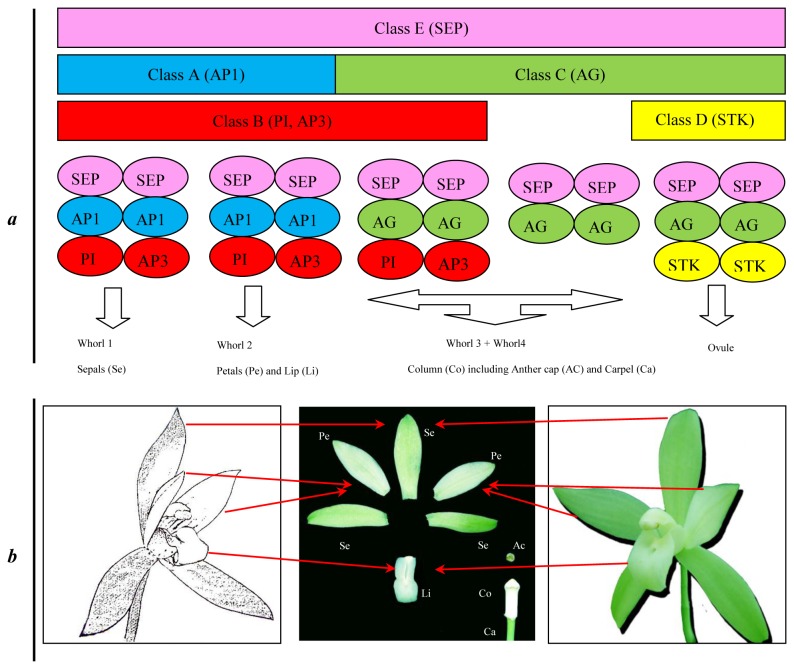
Diagram of the expanded ABCDE model of floral development.
a. In the model, A, B, C, D, and E class MADS-box proteins interact, leading to the formation of homodimers and heterodimers called “floral quartets.” The complexes then activate floral organ-specific expression programs [6-8]. Class A genes (APETALA1, AP1) control sepal development and, class A and class B genes (e.g., PISTILLATA, PI, and APETALA3, AP3) jointly regulate petal formation. Class B and class C genes (e.g., AGAMOUS, AG) jointly mediate stamen development. Class C genes determine the formation of carpel alone. Class D genes (e.g., SEEDSTICK, STK and SHATTERPROOF, SHP) specify the identity of the ovule within the carpel. Class E genes (e.g., SEPALLATA, SEP) are necessary for the proper formation of all floral organs. In orchids, male and female tissues fuse into a gynostemium or column. The orchid code theory suggests that class B AP3/DEF-like genes play a crucial role in lateral petal and lip identity and the class PI/GLO-like genes and the A, C, D and E class genes have unchanged function [8,50-52]. b. Floral organs of C. ensifolium. Se: Sepals (whorl 1); Pe: Petals and Li: Lip (whorl 2); Co: Column including Ac: Anther cap and Ca: Carpel (whorl 3+Whorl4).